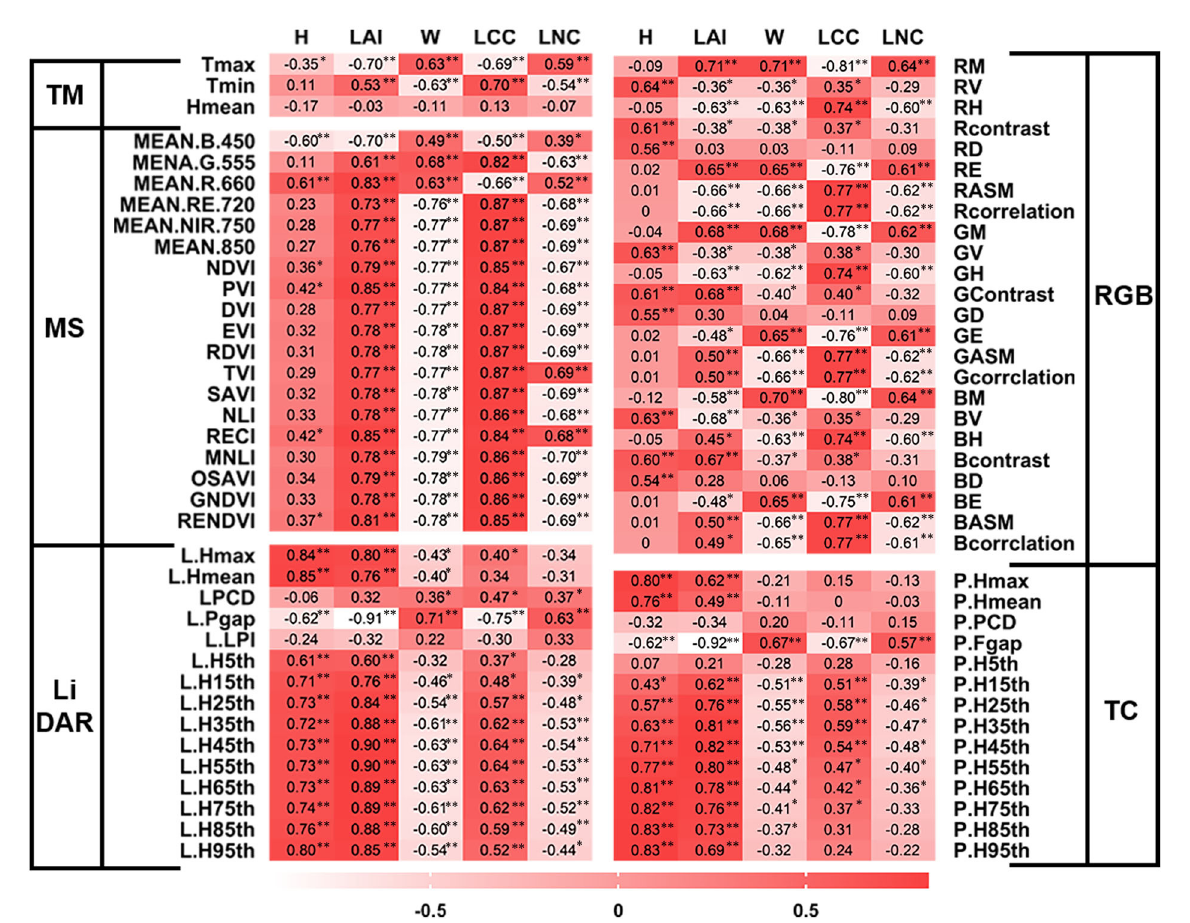
FIGURE6 Selected single-source remote sensing variables with high correlation. * and ** represent the significance levels of P < 0.05 and P < 0.01 , respectively.